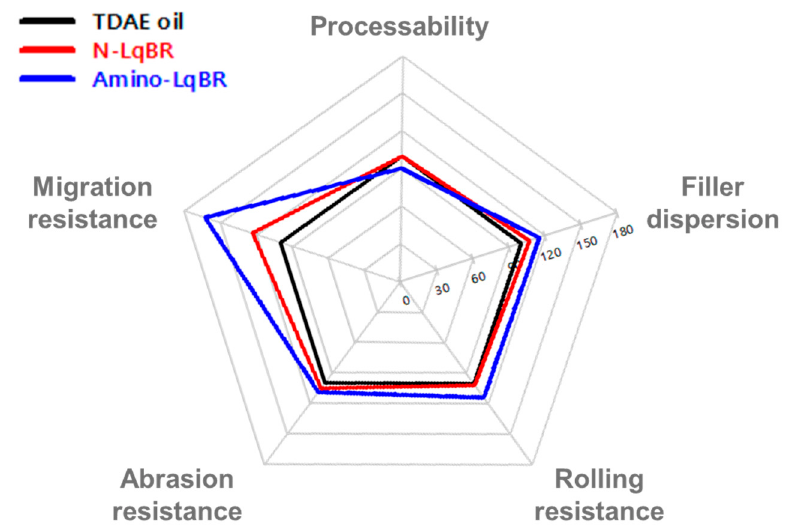
Figure 12. Performance of compounds with different processing aids applied.